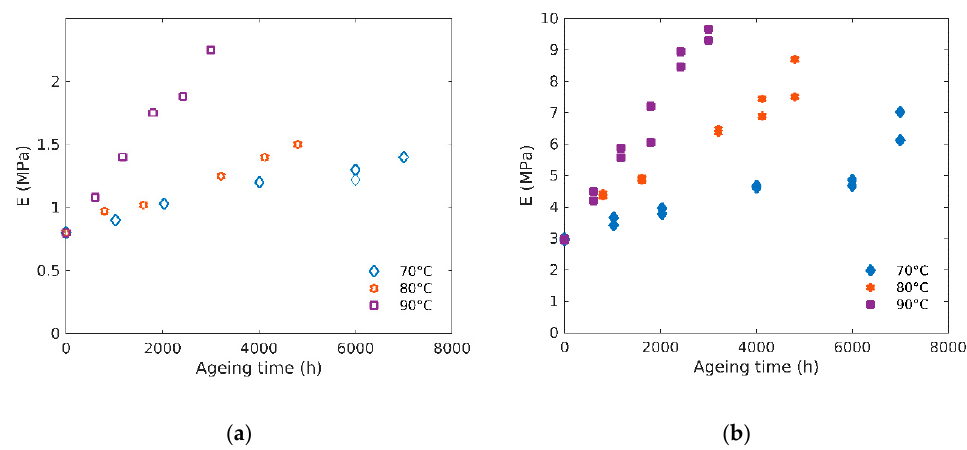
Figure 3. ( a ) Evolution of Young modulus ( E) with ageing time for unfilled and ( b ) filled rubbers at 70 °C, 80 °C and 90 °C.